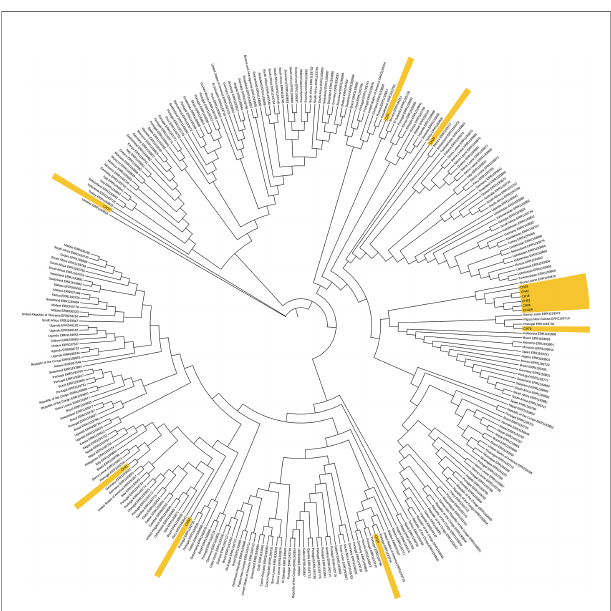
FIGURE 6 | Comparison of lineage 4.3.3 isolates from Chiapas to genomes of M. tuberculosis isolates obtained from Amazonic populations. Lineages of every isolate is marked with different colors in the